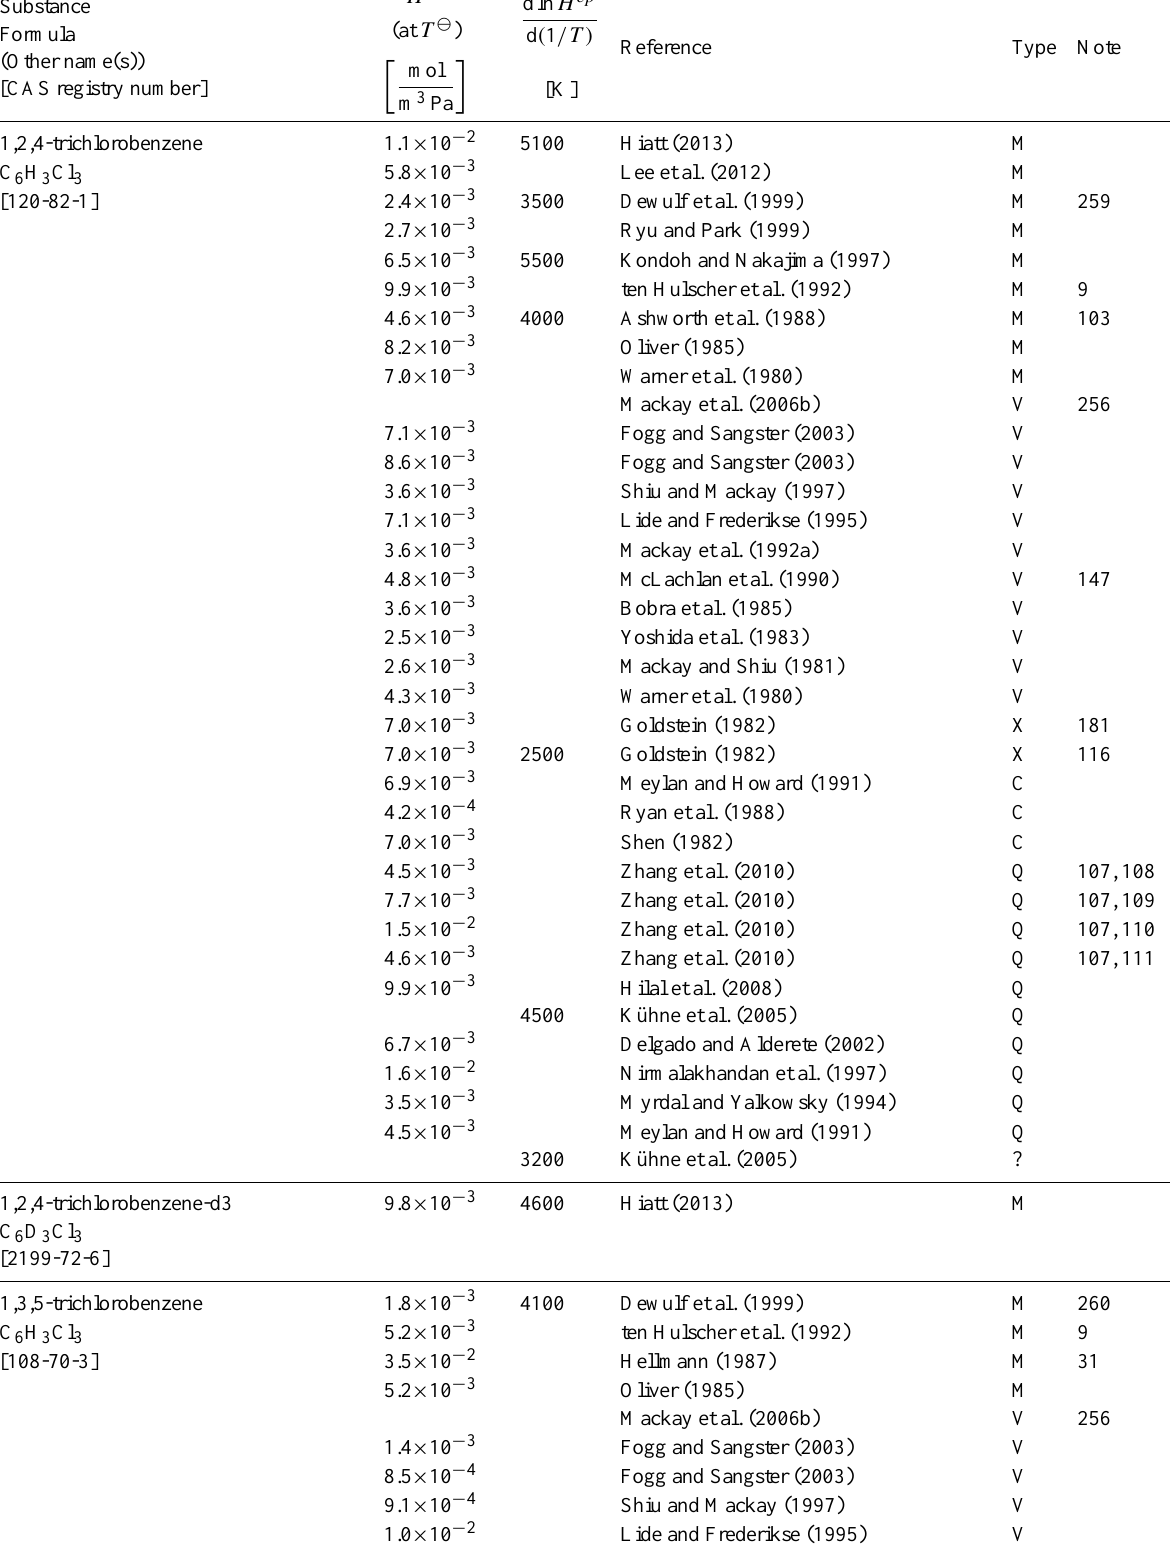
Table 6: Henry’s law constants for water as solvent